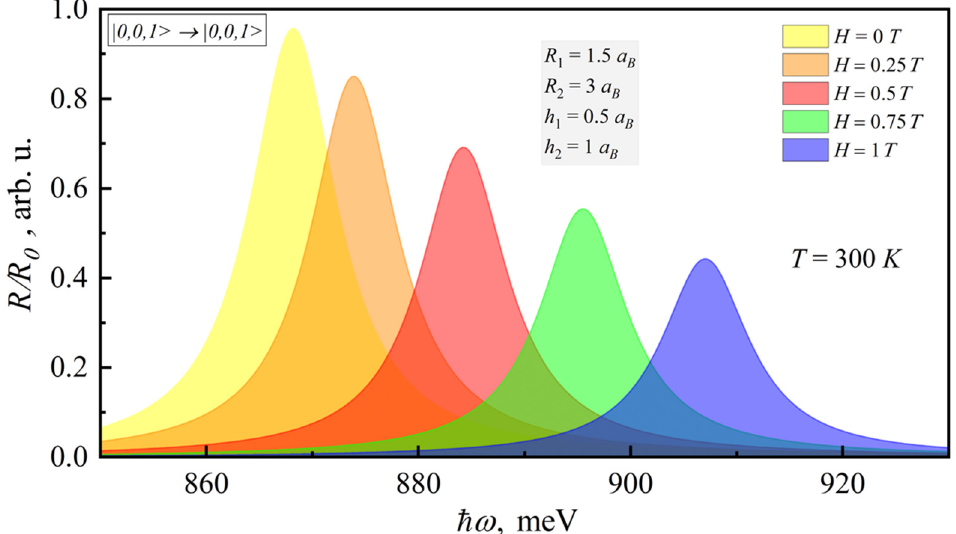
Figure 5. Dependence of the room-temperature PL coefficient on photonenergy for different magnetic fields.